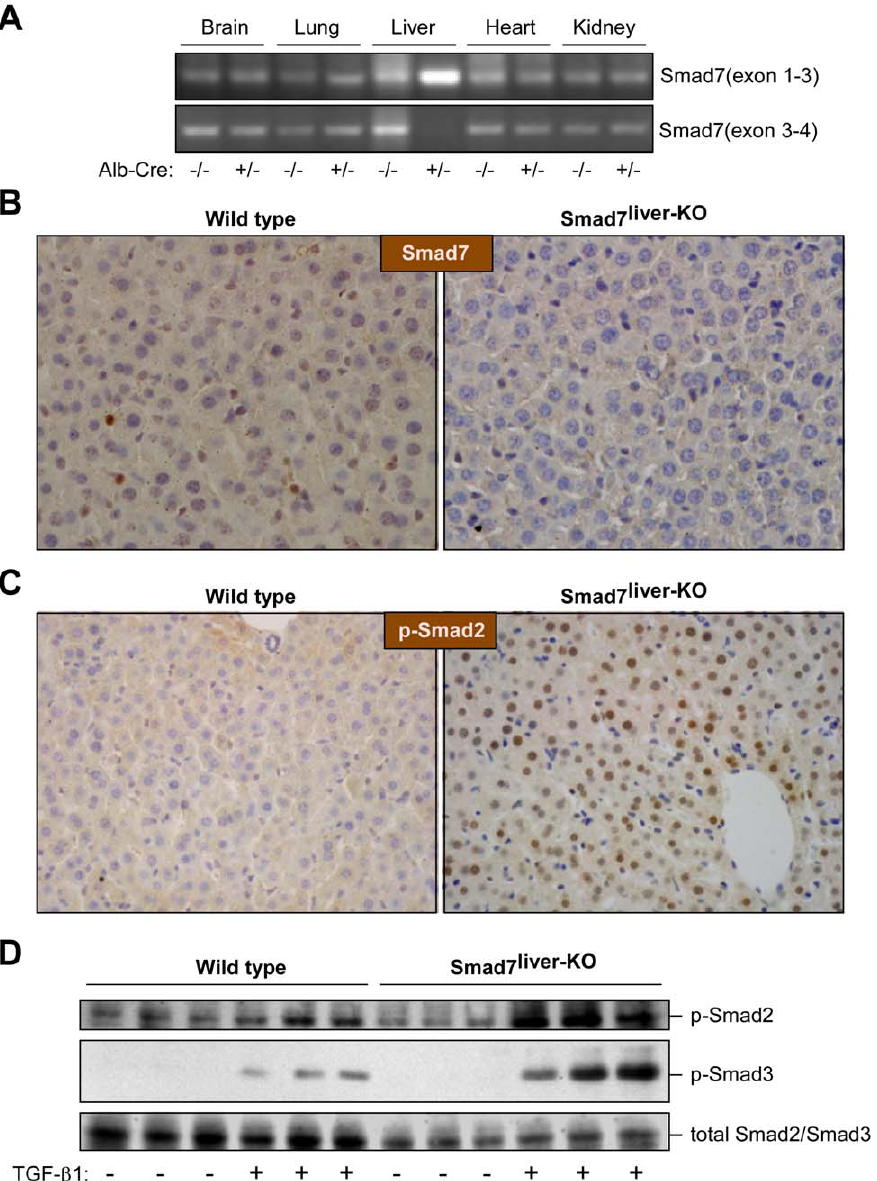
Figure 1. Characterization of Smad7 liver-KO mice. (A) Liver-specific deletion of Smad7. RT-PCR analysis was performed with total RNA isolated from multiple tissues in Alb-Cre heterozygous or wild type mice (all mice having Smad7 loxP/loxP ) with specific primers that amplify mRNA regions corresponding to exons 1–3 or exons 3–4 of Smad7 respectively. (B) Analysis of the Smad7 by immunohistochemistry staining. Representative liver sections (400 X) from wild type and Smad7 liver-KO mice were used in immunohistochemistry staining with an anti-Smad7 antibody. The nuclei were stained with haematoxylin. (C) Smad2 phosphorylation is elevated in the liver of Smad7 liver-KO mice. Smad2 phosphorylation was analyzed by immunohistochemistry using liver sections from either wild type or Smad7 liver-KO mice. The nuclei were stained with hematoxylin. Note that nuclear phospho-Smad2 staining is increased in the liver of Smad7 liver-KO mice. (D) TGF- b -induced Smad2 and Smad3 phosphorylation is enhanced by Smad7 deletion in primary hepatocytes. Immunoblotting was performed using total protein lysate extracted from primary hepatocytes using antibodies as indicated. The cells were treated with or without 5 ng/ml of TGF- b 1 for 24 hours as indicated after overnight serum starvation.